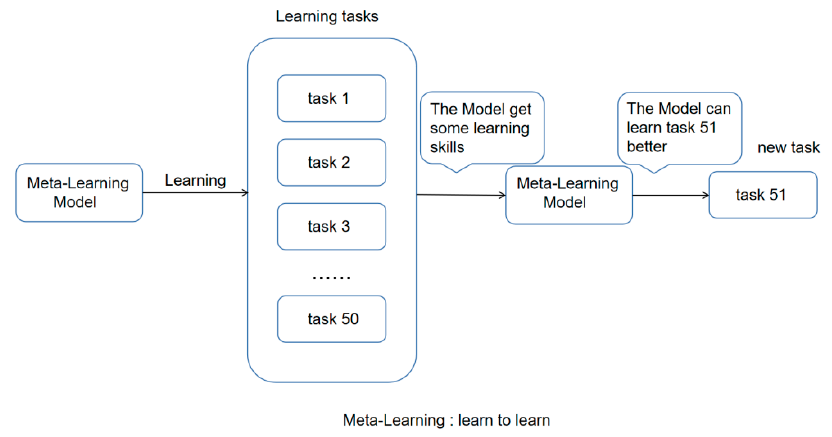
Figure 1. The learning progression process of the meta-learning model.